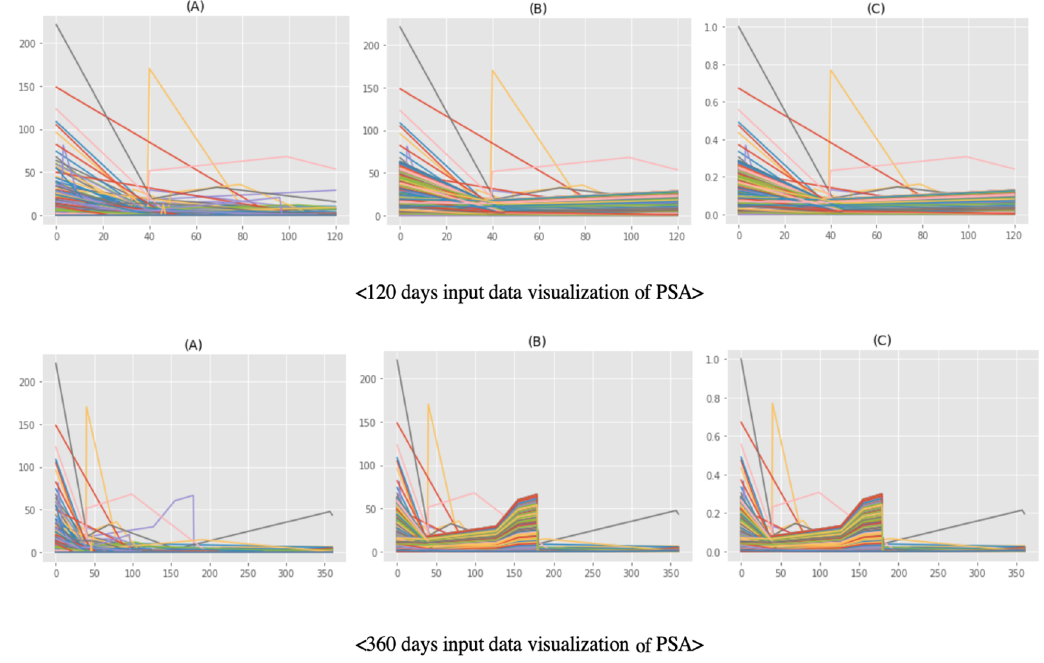
Figure 5. Shape of the input data for prostate specific antigens: ( A ) prior data, ( B ) oversampling result from prior data, and ( C ) scaling result from oversampling data.